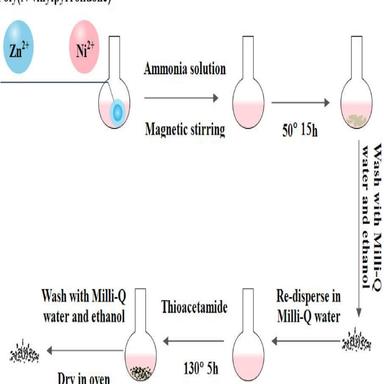
Schematic of the synthetic route of ZnS/Ni3S2 electrode materials.